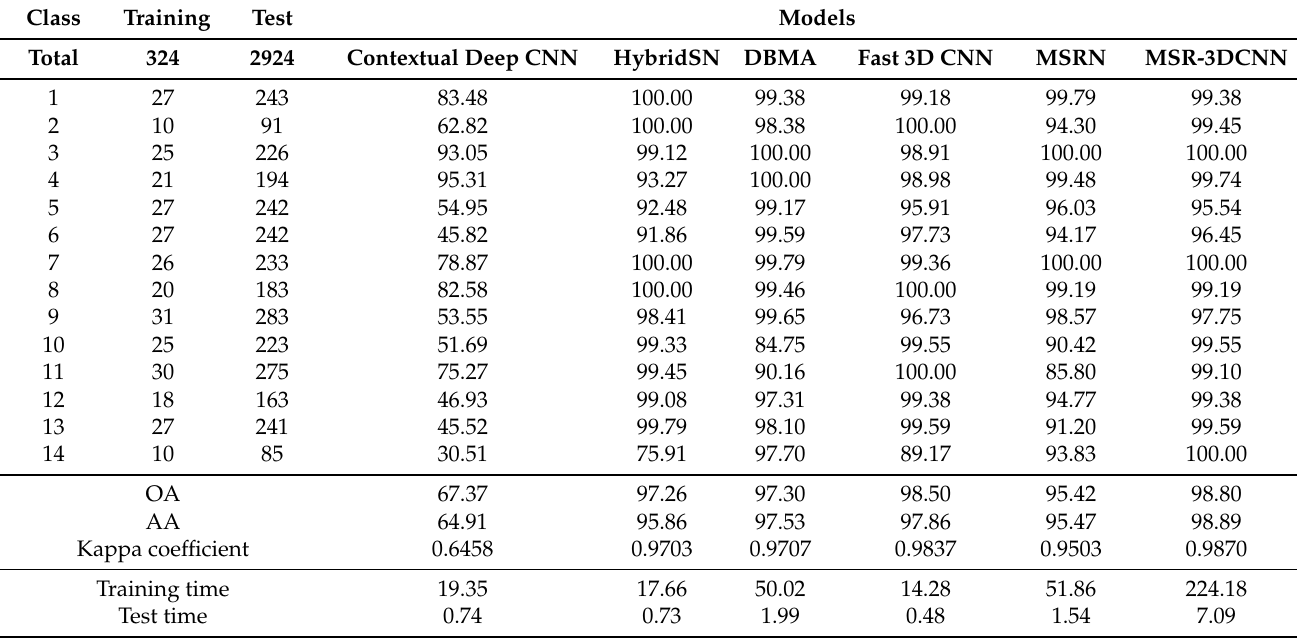
Table 3. F1 Score (%) for Each Class, OA (%), AA (%), and Kappa Coefficient Values for the entire dataset, training time (s), and test time (s) using ( 9 × 9 ) patch size and 10% samples for training on the BO datasets.